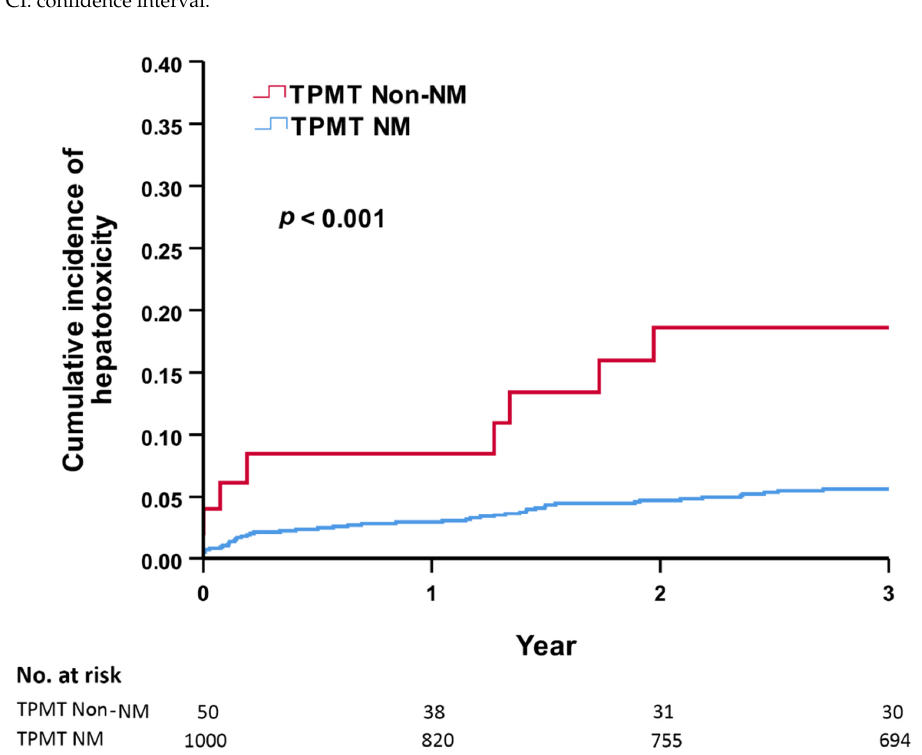
Figure 2. Three-year cumulative incidence of hepatotoxicity between the TMPT non-NM and NM groups. TPMT, thiopurine S-methyltransferase; NM, normal